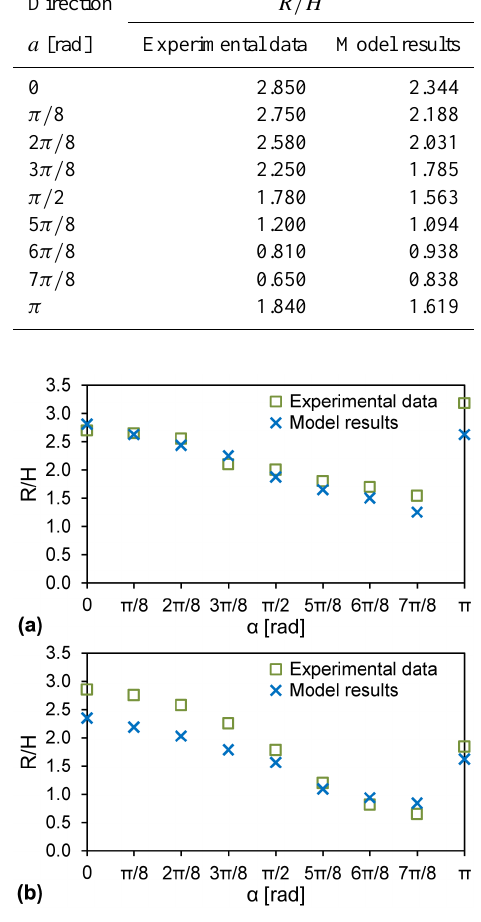
Figure 2. Tsunami run-up on a circular island: comparison of the normalized maximum run-up height ( R/H) distribution around the island between model results and the measurements of Briggs et al. (1995) for (a) ε = 0 . 10 and (b) ε = 0 . 20; the angle α = 0 corre- sponds to the front direction of the wave approaching the island and α = π to the back direction. higher discrepancy observed only at a = π . For ε = 0 . 20, the model seems to relatively underestimate run-up at the front part of the island, while from α = π/ 2 to α = π calculated R/H values are again very close to